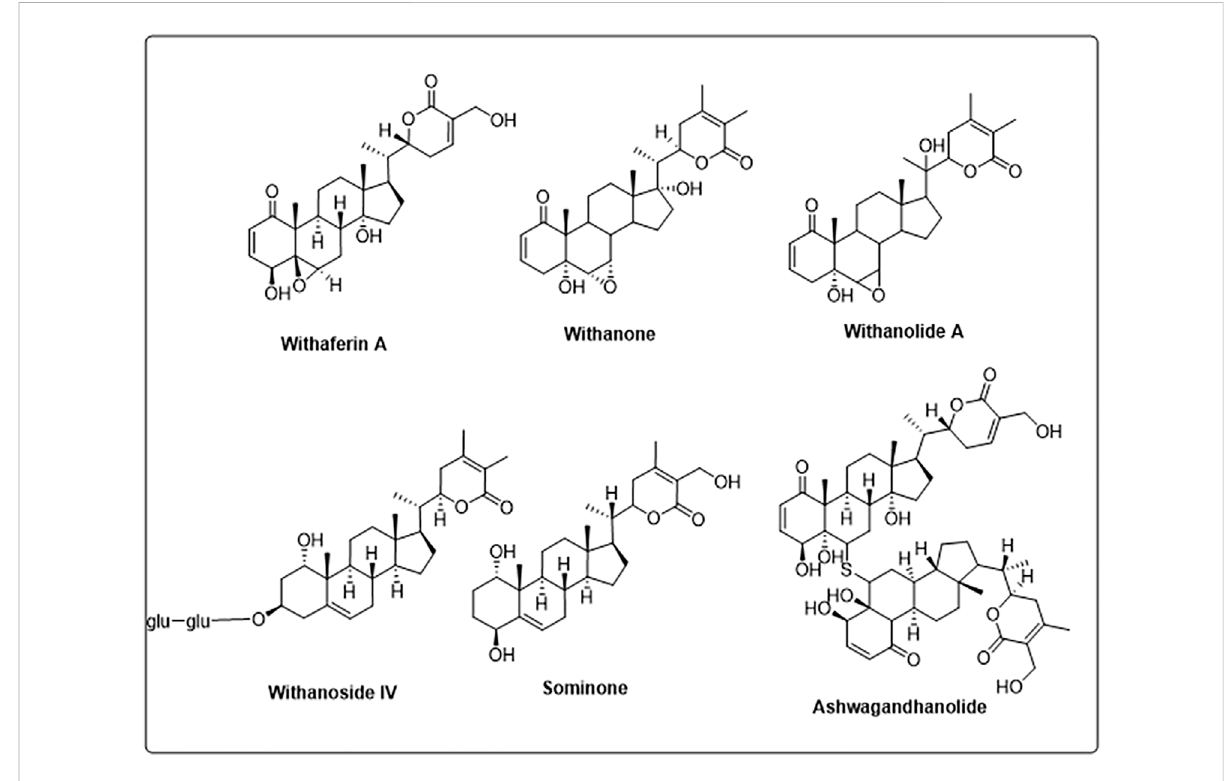
FIGURE 2 Structure of different phytochemicals from Withania somnifera